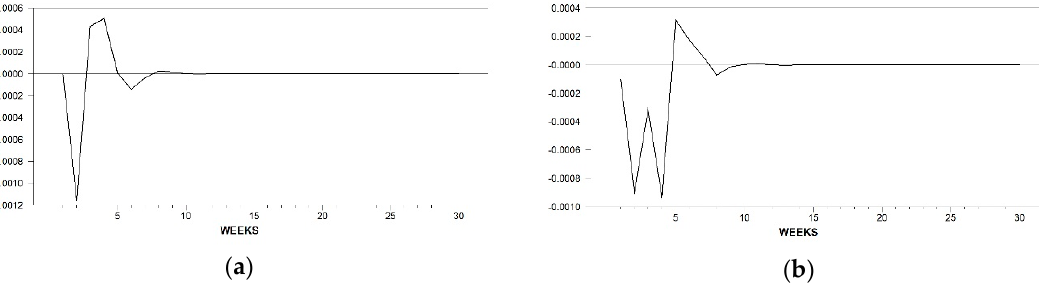
Figure 3. IRF for the generic Caciotta cheese. ( a ) Response of retail price to a shock in farm price; ( b ) Response of farm price to a shock in retail price.